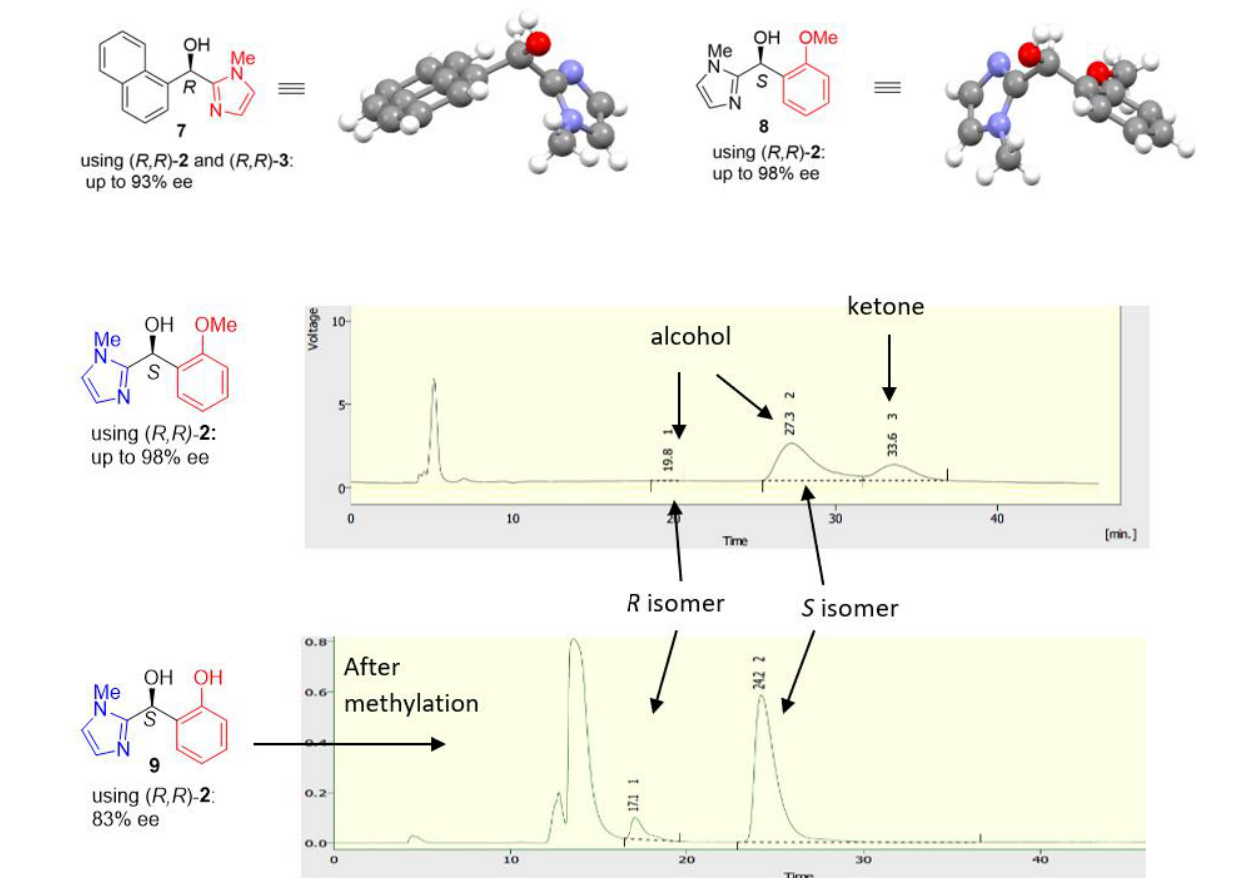
Figure 18. Determination of configuration of ATH products containing imidazole groups.